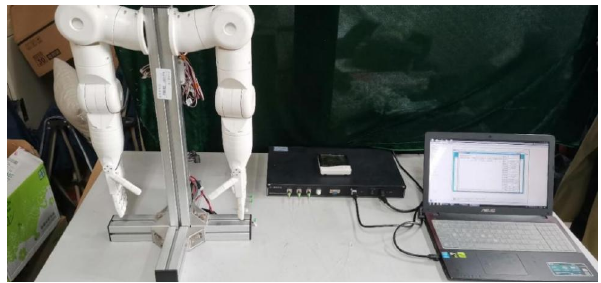
Figure 26. Robot perception test system